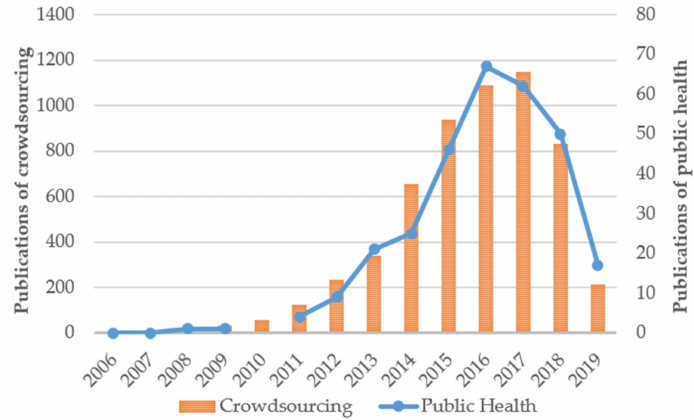
Figure 2. Numbers of publications related to crowdsourcing and crowdsourcing research in the field of public health in the WOS core collection, published from 2006 to 2019.